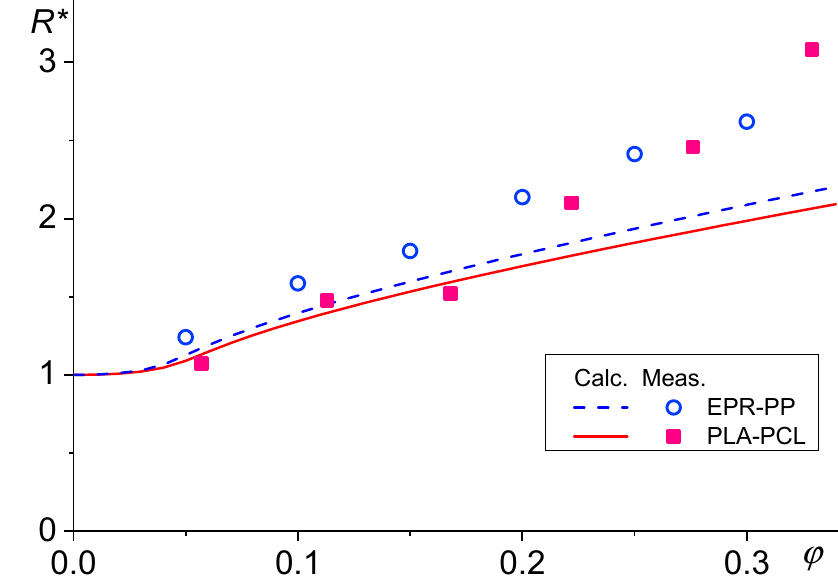
Figure 7. Reduced droplet sizes calculated using Equation (64) and experimental sizes for blends ethylene-propylene rubber (EPR)-polypropylene (PP) [112] (dashed line and empty circles) and poly(lactic acid) (PLA)-poly(caprolactone) (PCL) [113] (solid line, full squares)